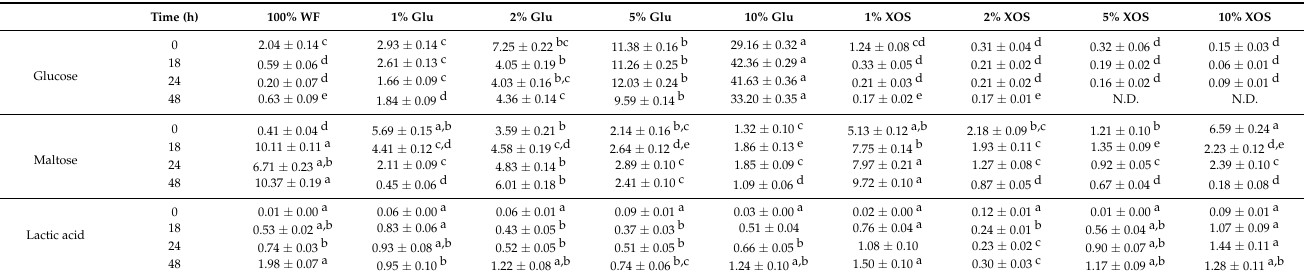
Table 1. Quantity of glucose, maltose, and lactic acid (mg/L) during fermentation.